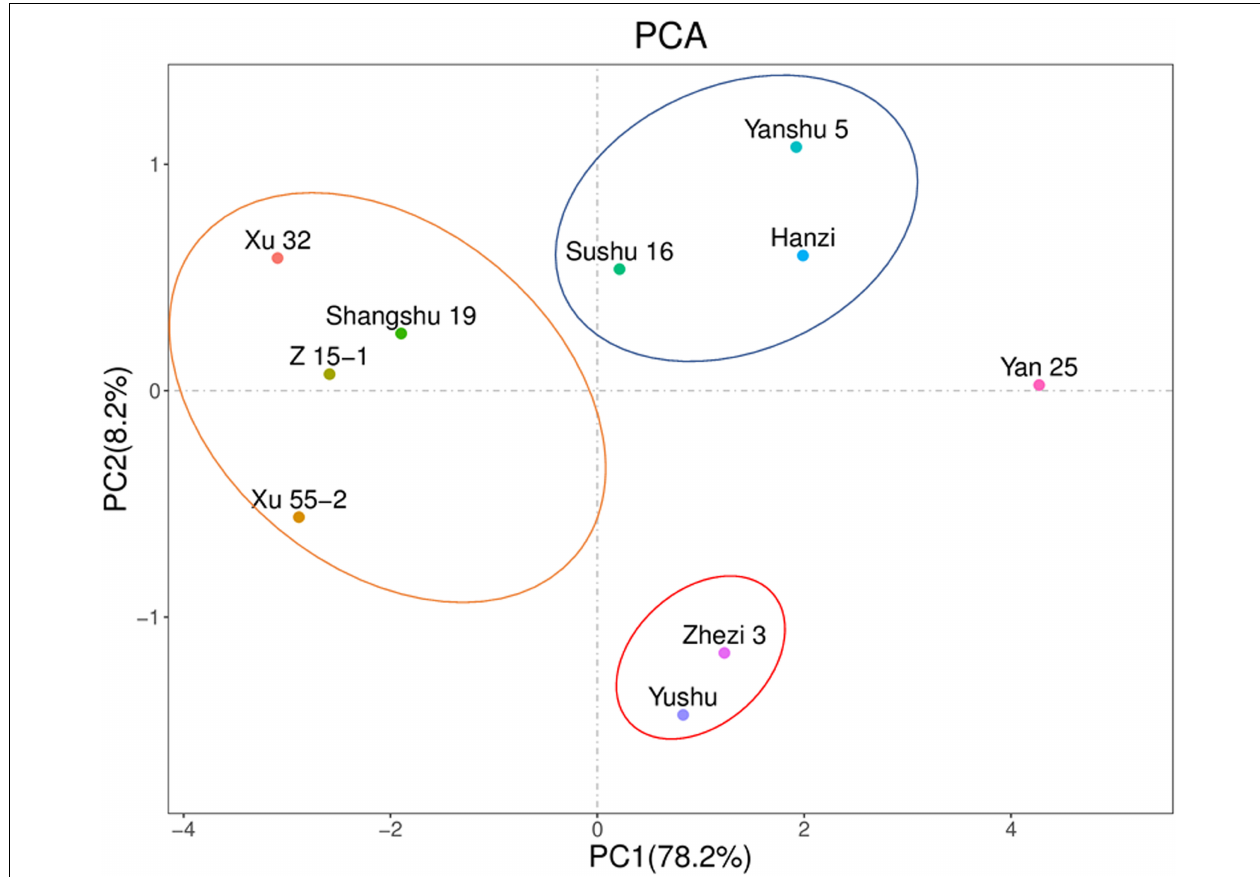
FIGURE 4 | Principal component analysis based on antioxidant-related enzyme activities and reactive oxygen species (ROS) contents in 10 sweet potato cultivars (i.e., Xu 32, Xu 55-2, Z 15-1, Shangshu 19, Sushu 16, Yanshu 5, Hanzi, Yushu, Zhezi 3, and Yan